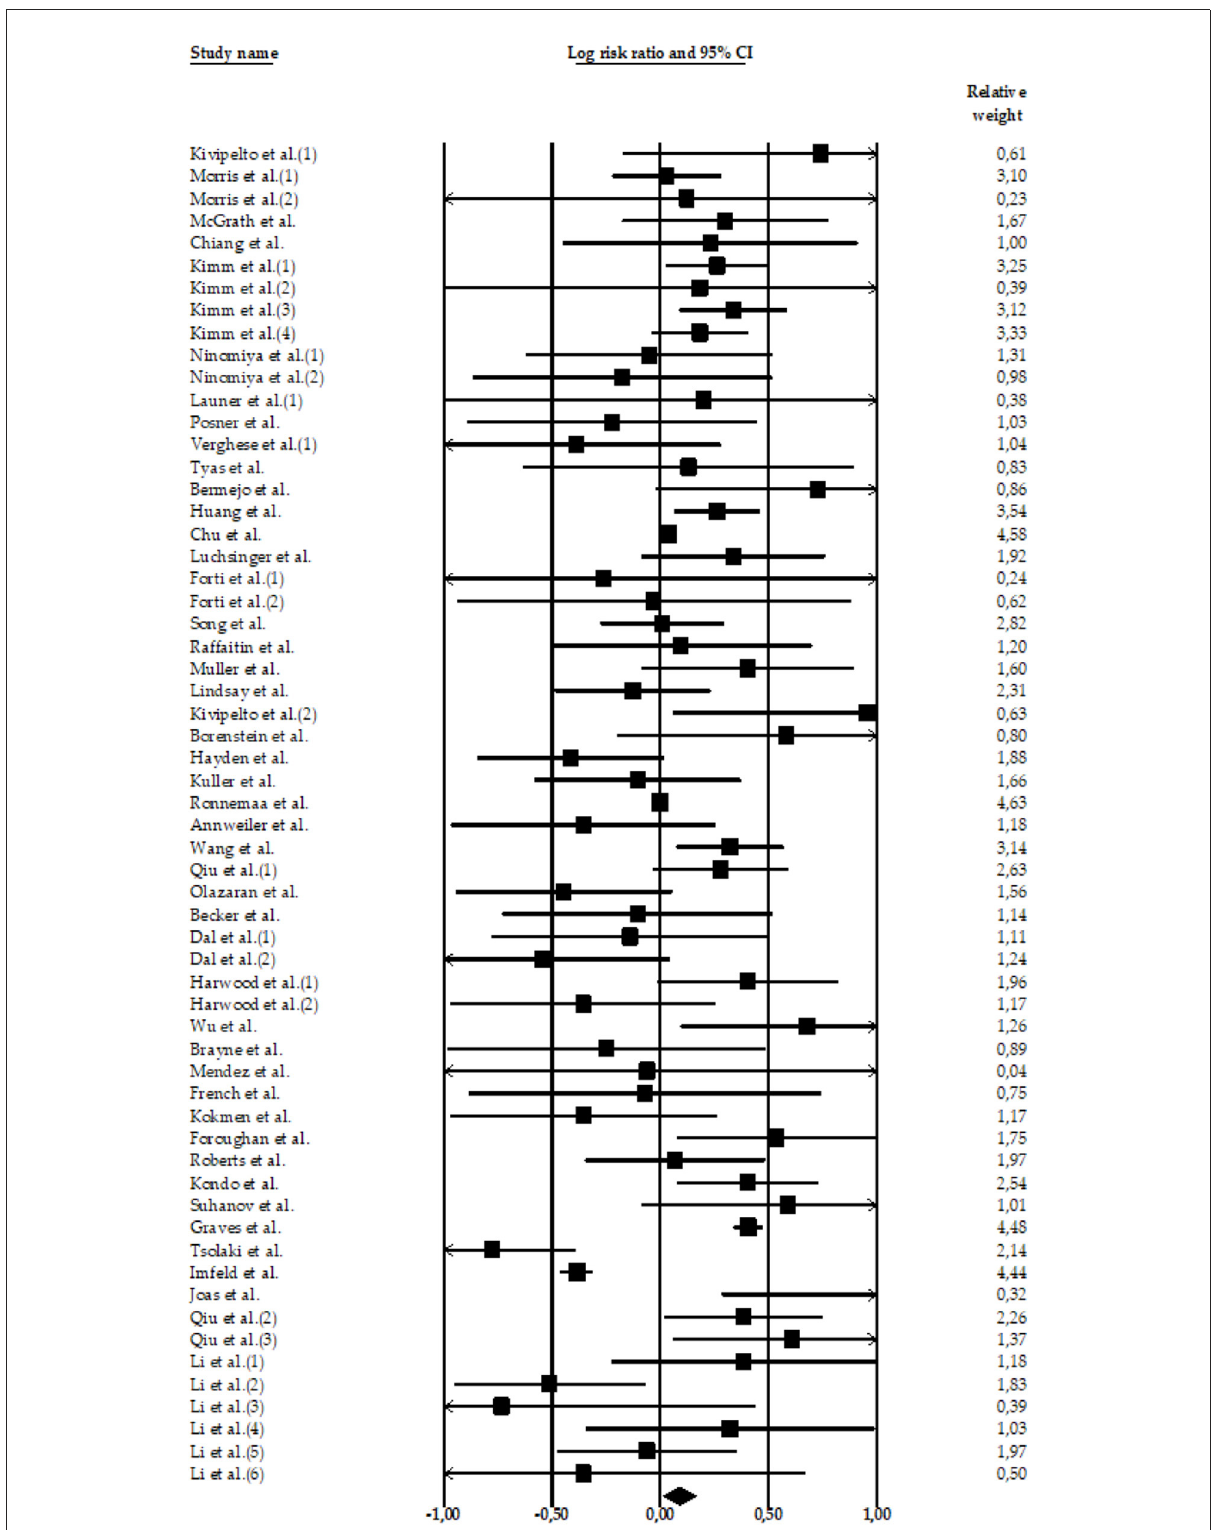
FIGURE2 Forest plot of the meta-analysis of incidence rates of AD in participants with high SBP. Individual and pooled estimates of the association between measures of hypertension and AD. The size of the box representing the point estimate for each study in the forest plot is proportional to the contributing weight of that study estimate to the summary